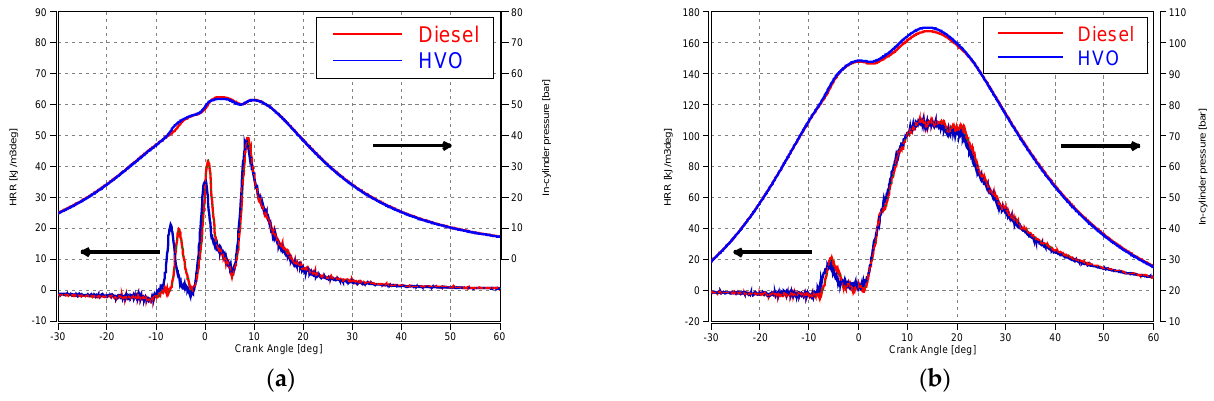
Figure 1. In-cylinder pressure and heat release rate for diesel and HVO at 1250 × 2 ( a ) and 2250 × 15 ( b ).